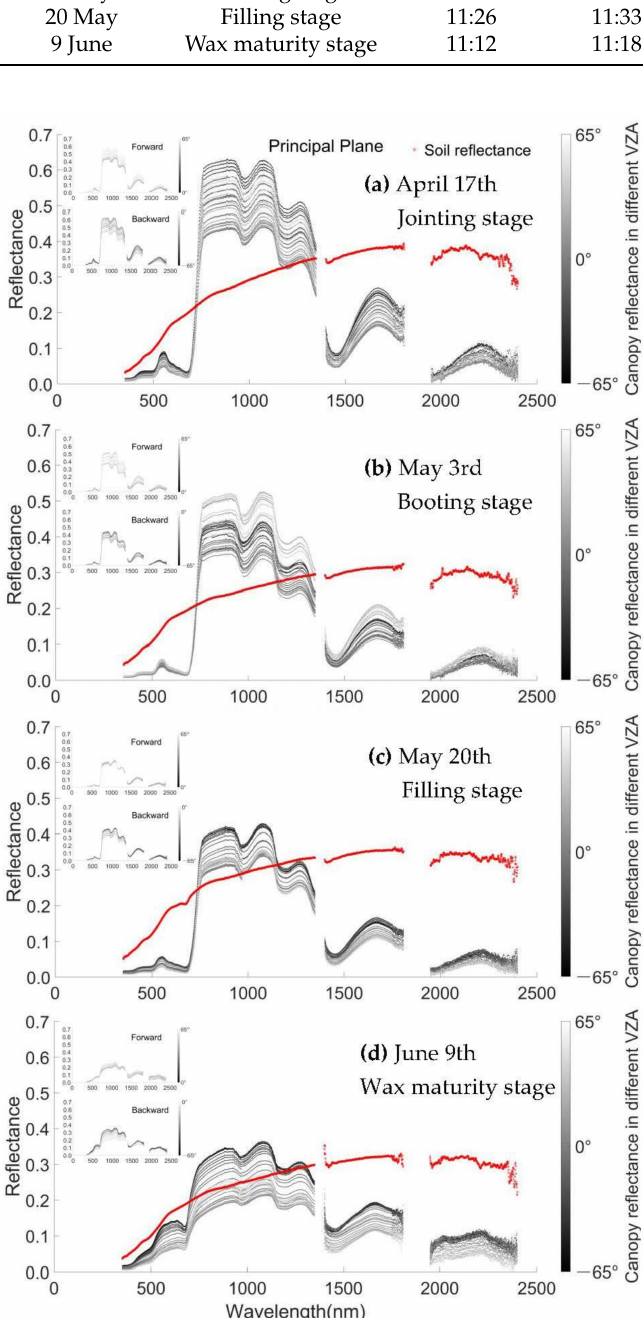
Figure 4. Ground-based hyperspectral reflectance of winter wheat canopy at VZA varying at [ − 65 ◦ , 65 ◦ ] with a step of 5 ◦ in the principal plane on ( a ) April 17 (jointing stage), ( b ) May 3 (booting stage), ( c ) May 20 (filling stage), and ( d ) June 9 (wax maturity stage), with the background soil reflectance in scattered red